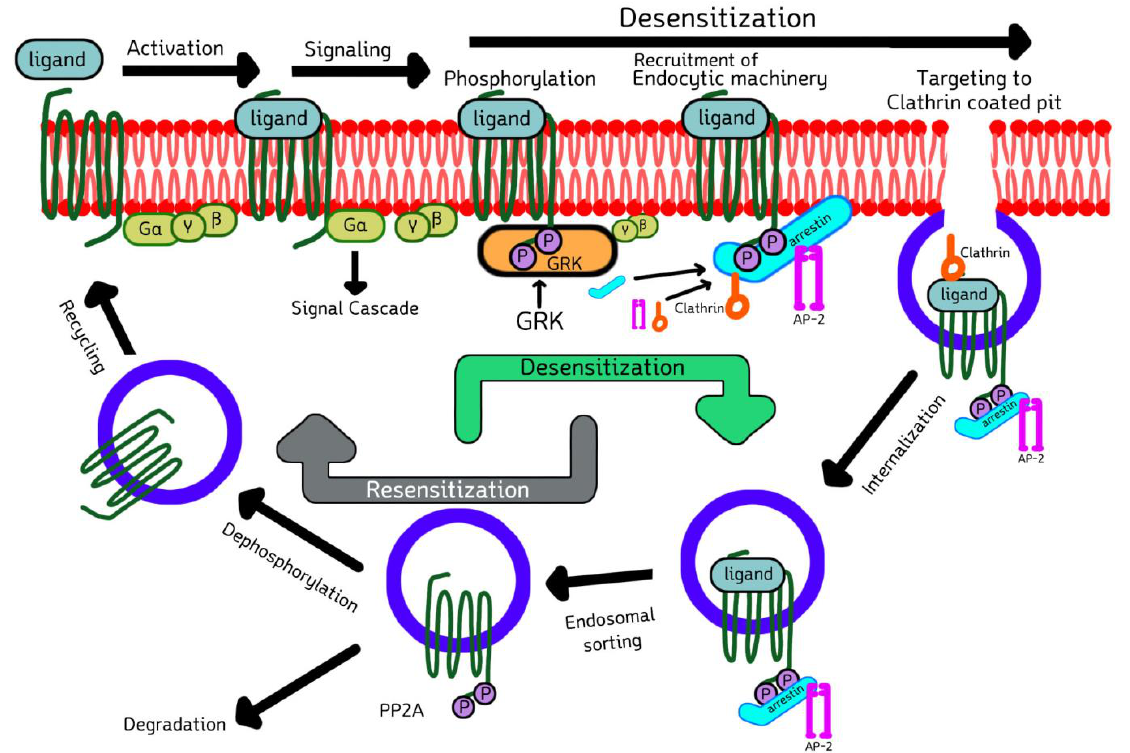
Figure 3. Model depicting GRKs and arrestins in the signaling, desensitization and internalization.The activated 7-TM receptor/GPCR is phosphorylated by GRK enabling arrestin recruitment and terminating G-protein coupling, finally desensitizing GPCR downstream signaling by mediating the arrestin–receptor complex to clathrin-coated pits. This promotes receptor internalization. The internalized receptor is finally sorted either by degradation or recycling. Refer to the text for a detailed mechanism. Modified from Mohan et al. [39].